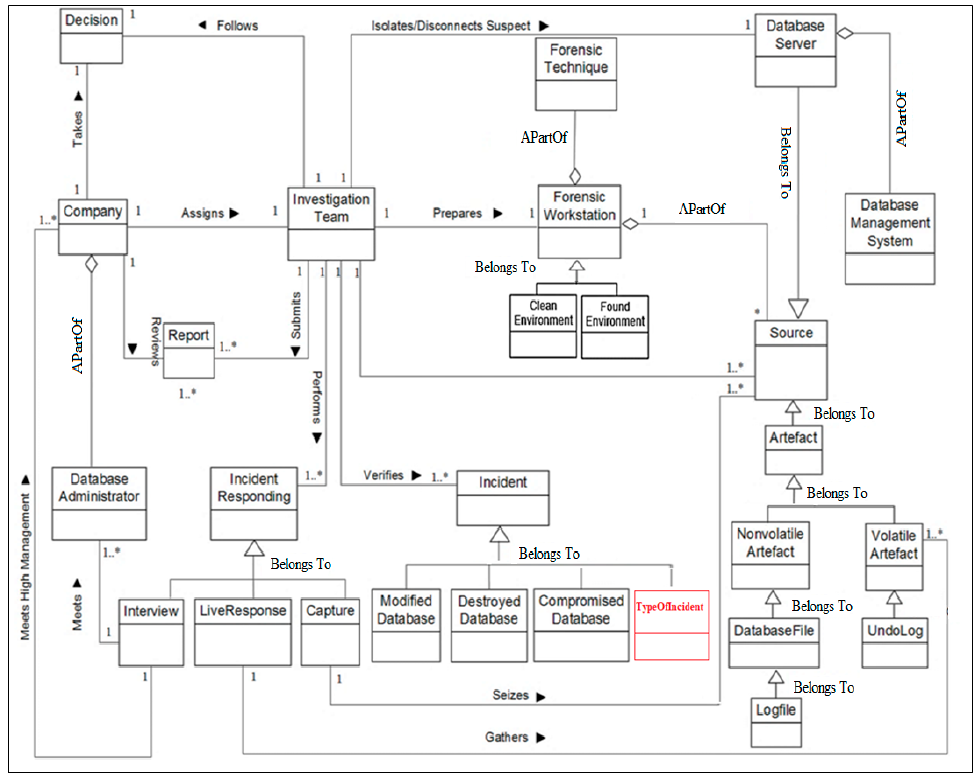
Figure 6. Validated DBFIM Identification Class 1.